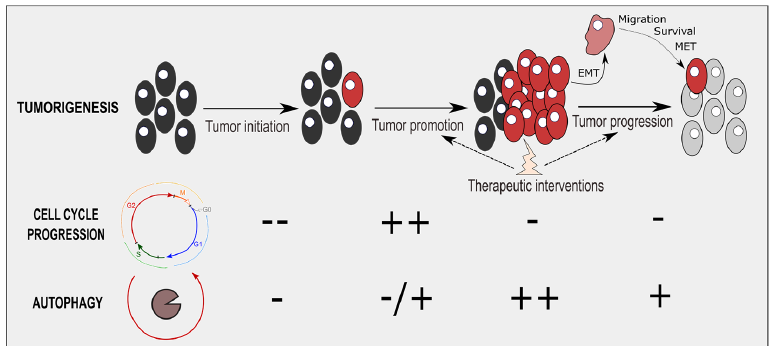
Figure 4. Cell-cycle and autophagic processes during tumorigenesis. During tumor initiation, the cell tumor initiation step, notably via the degradation of oncogenic molecules. During tumor promotion, cell-cycle progression is reactivated while autophagy is partly enhanced. Tumor progression, notably through epithelial-mesenchymal transition (EMT), migration, survival, and mesenchymal-epithelial transition (MET), reduces drastically cell-cycle progression, while enhancing autophagic